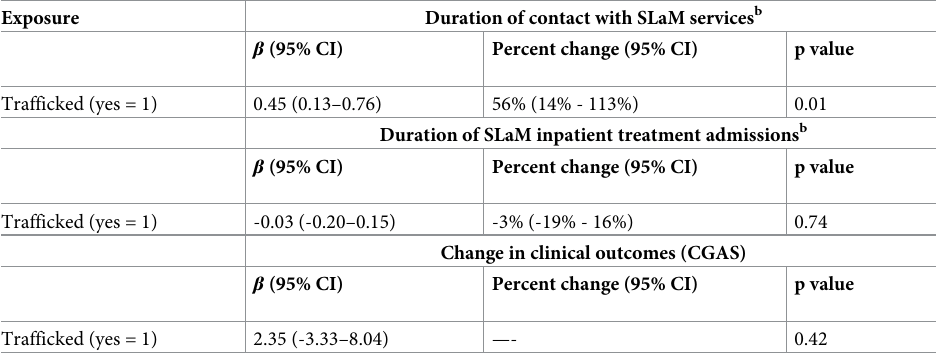
Table 4. Multiple random effect regression analyses comparing care pathways and clinical outcomes of trafficked and matched non-trafficked children in contact with secondary mental health services a